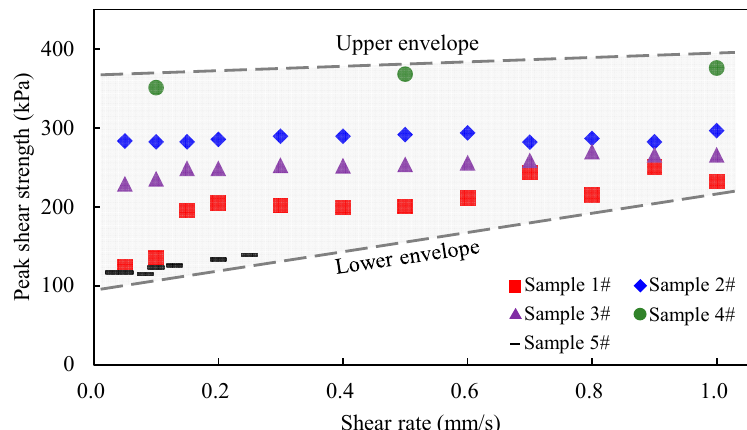
Figure 3. Peak shear strength of granite discontinuity samples under different normal stresses and shear rates.